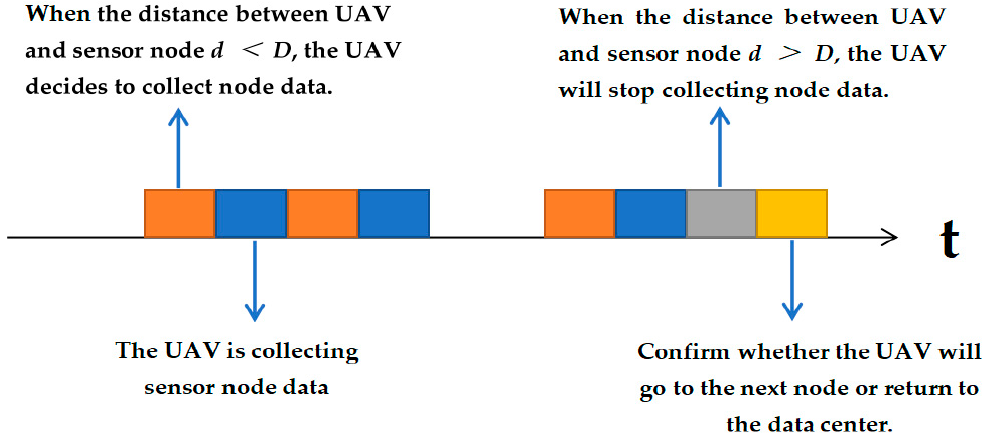
Figure 2. Data collection diagram.